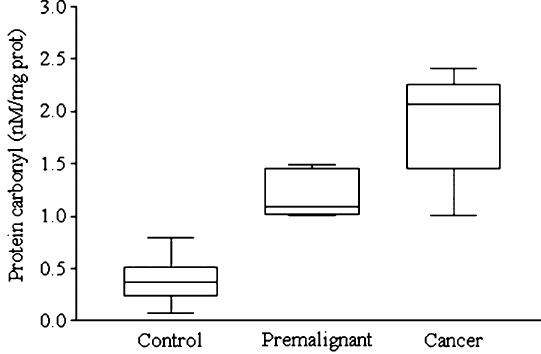
Fig. 1. Median levels of protein carbonyls in NAF collected from Control subjects ( n = 216), from patients histologically catego- rized at the time of NAF collection as affected by pre-malignant con- ditions (e.g., hyperplasia with atypia, papilloma with atypia) who within five years developed BC (Pre-malignant, n = 14), and from patients who had biopsy proven confirmed ductal carcinoma in situ and invasive breast cancer ( n = 58). (Control vs. Pre-malignant, p < 0 . 0001; Control vs. Cancer, p < 0 . 0001; Pre-malignant vs. Cancer, p < 0 .